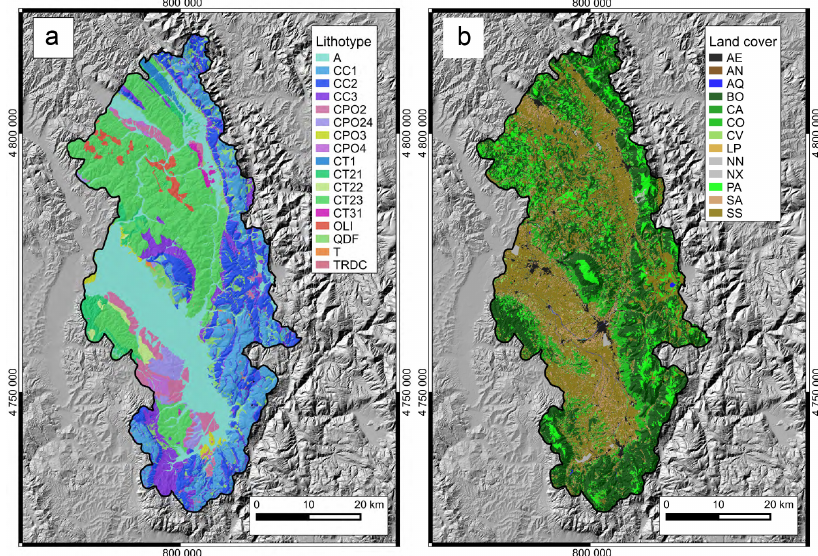
Figure 5. (a) Lithological map of upper Tiber River basin, Umbria, central Italy (Regione Umbria, 1995–2015). Details of the lithological types are given in Table 1. (b) Land use map of the study area. Legend: AE: urban area, AN: bare soil, AQ: water, BO: forest, CA: orchard, CO: olive grove, CV: vineyard, LP: poplar trees, NN/NX: unclassified, PA: meadow/pasture, SA: treed seminative, SS: simple seminative. The maps are in the UTM zone 32, datum ED50 (EPSG:23032) reference system.